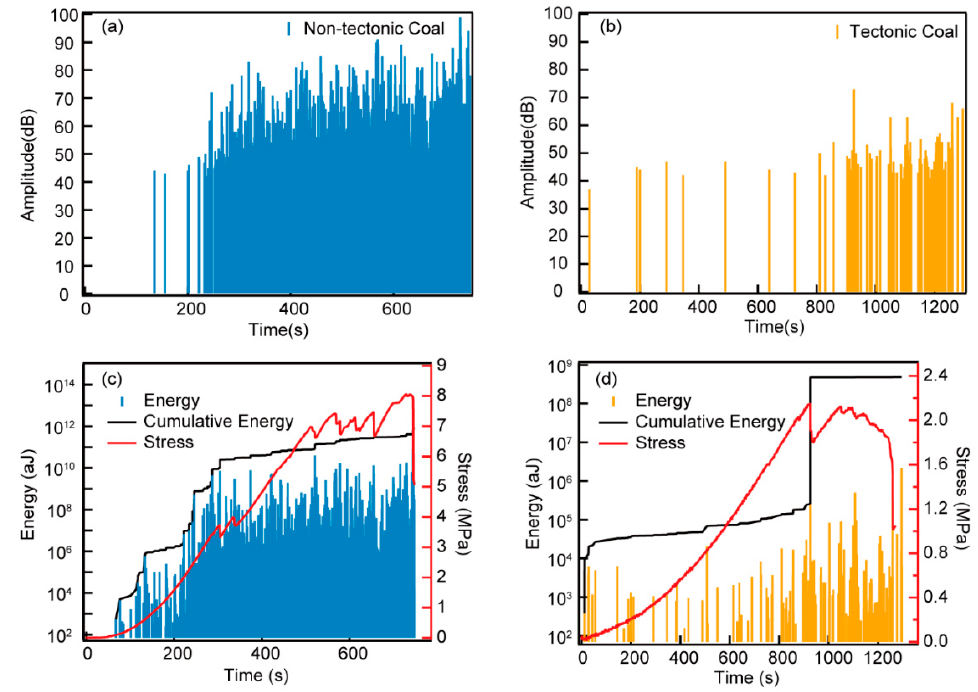
Figure 3. ( a , b ) are AE amplitude for non-tectonic and tectonic coal. ( c , d ) are AE absolute energy spectrum, cumulative energy curves, and compression stress curves for non-tectonic and tectonic